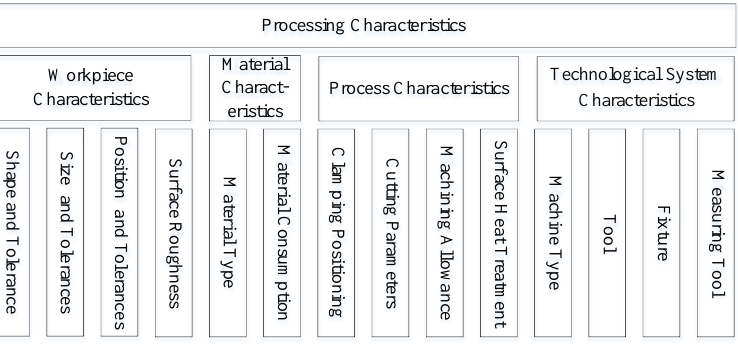
Table 4. Quantities corresponding to each machining feature.